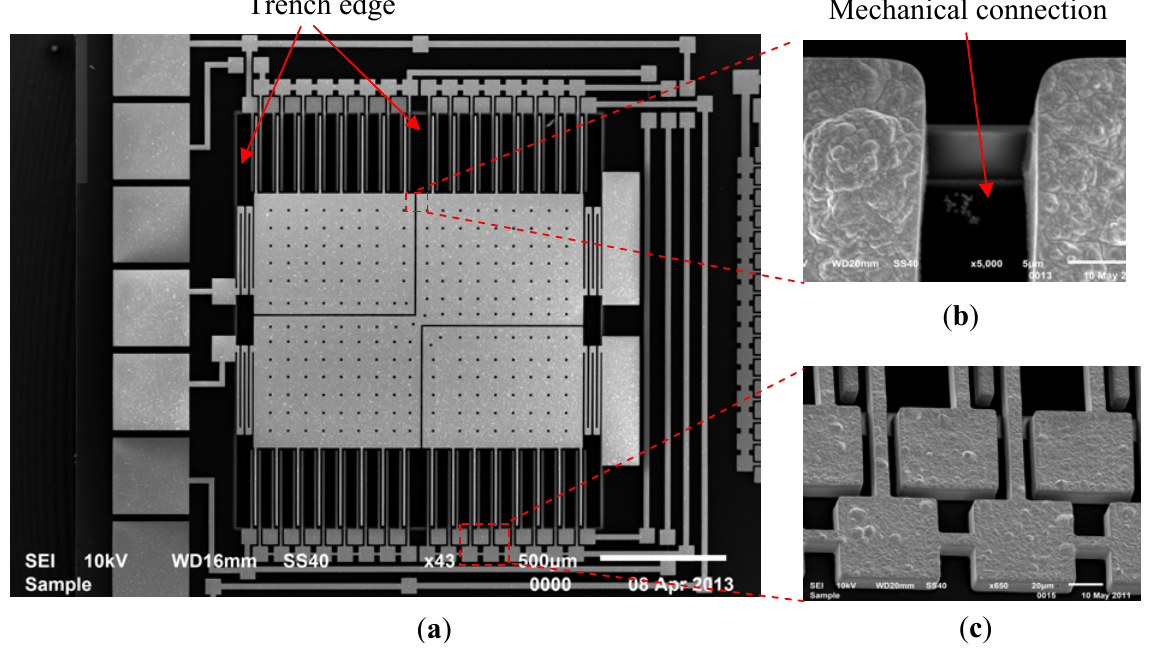
Figure 8. ( a ) The SEM image of a released sensor, ( b ) mechanical connection of proof mass pieces, and ( c ) anchors of the stator sensing